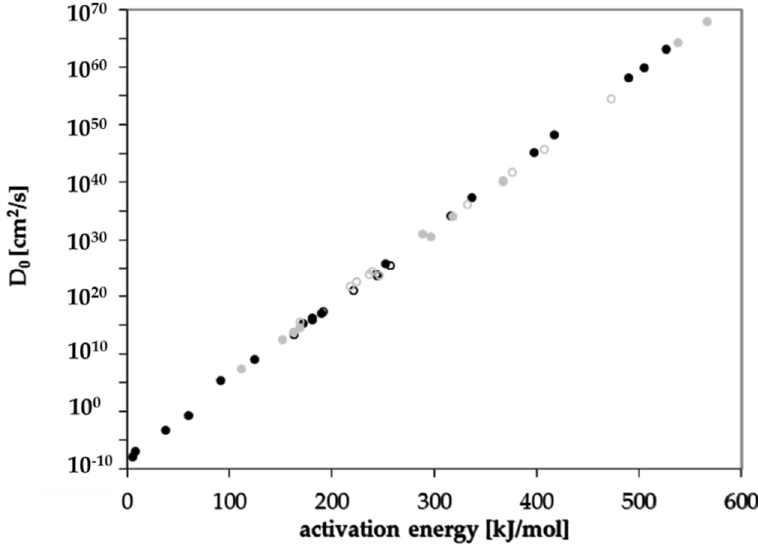
Figure 5. Correlation between the pre-exponential factor D 0 and the activation energy of diffusion E A below T g (solid dots, solid line) and above T g (non-solid dots, dashed line): black dots GPPS, grey dots HIPS.